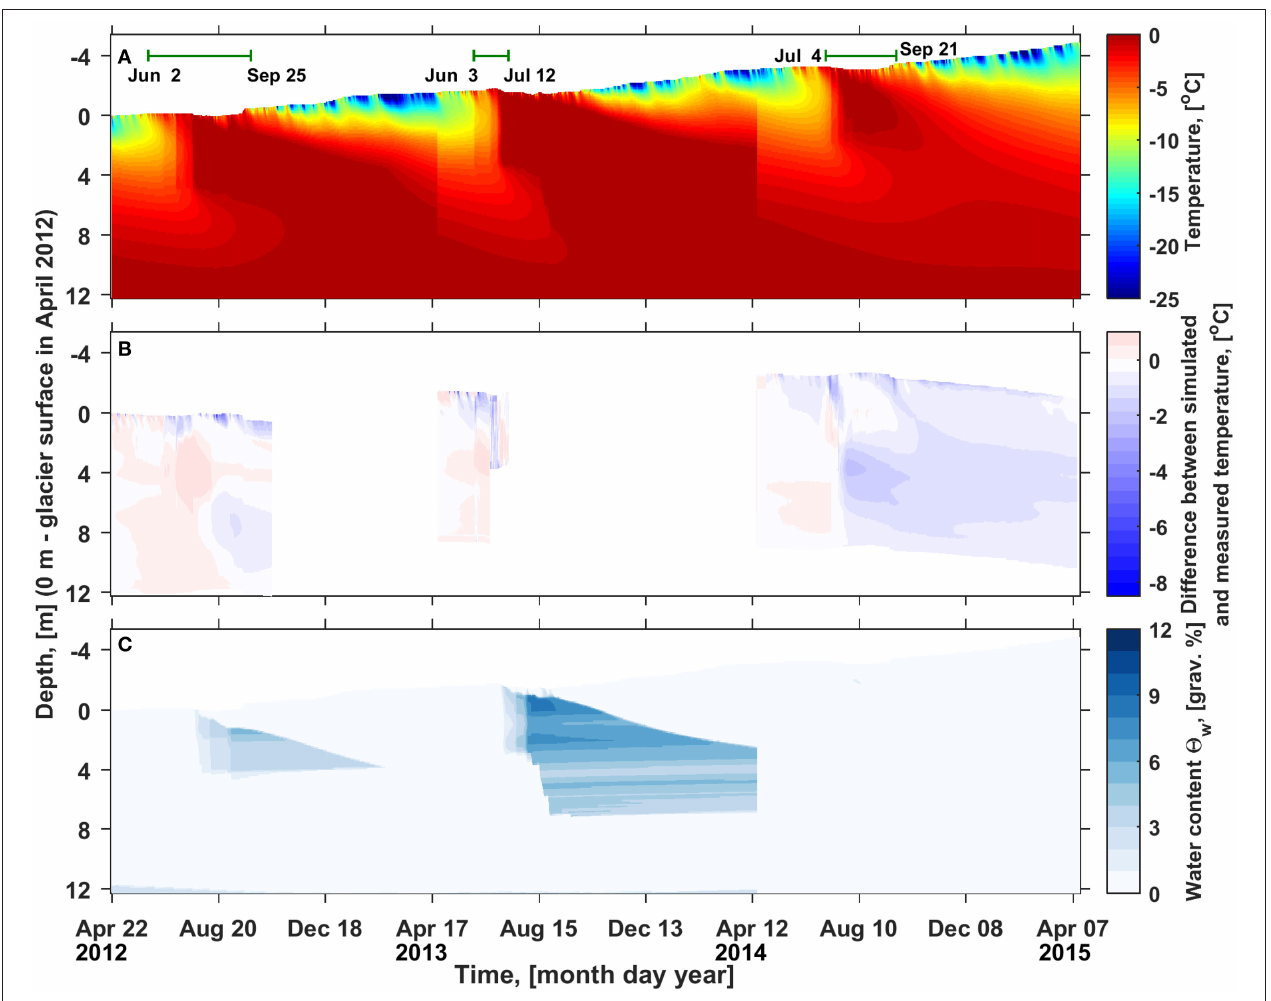
FIGURE 12 | (A) Evolution of the snow and firn temperature simulated using E 0 Wm − 2 and the uniform law water infiltration scheme with z lim =5 m, + = corresponding to the average of z lim values resulting in minimal RMSD for the summer seasons 2012 – 2014. Green bars in the upper part of the panel mark the time intervals used in calculations presented in Figure 11 . Resetting the simulated temperature profile to the measured values on the 23rd, 18th, and 16th April 2013, 2014, and 2015, respectively causes the sudden shifts in temperature evolution. (B) Difference between the simulated (A) and measured ( Figure 8A ) temperature evolution. Values larger than 1 ◦ C constitute ca 2.3% and are shown as 1 ◦ C. (C) Evolution of the simulated gravimetric water content ( 2 w ). Note: the color scales are the same as in Figure 10